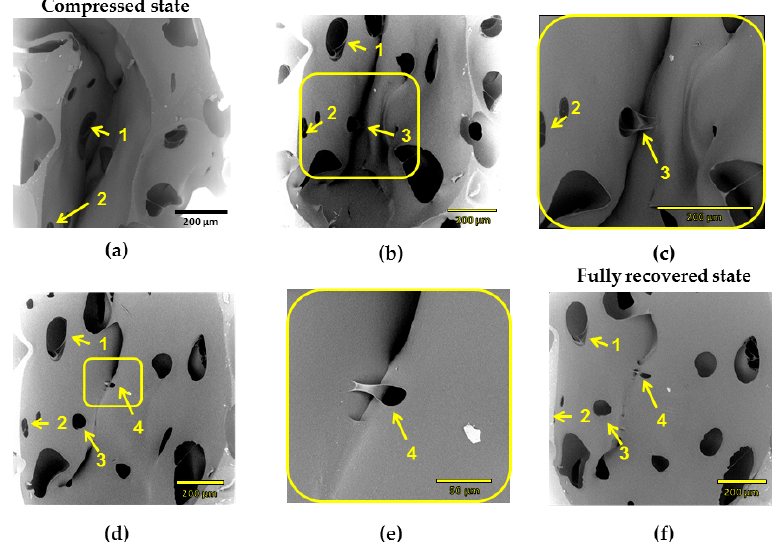
Figure 10. Scanning electron microscopy (SEM) images of stepwise recovery from compressed state ( a ) of intermediate density foam (cPCL-2/4/8k-180) up to the full recovered state ( f ). ( c ) Magnification of window (3) in ( b ). ( e ) Magnification of window (4) in ( d ) at an intermediate compression ratio. Yellow arrows with numbers indicate specific wall elements discussed in the text. Scale bars for images ( a – d ) and ( f ) are 200 µ m; scale bare for image ( e ) is 50 µ m.